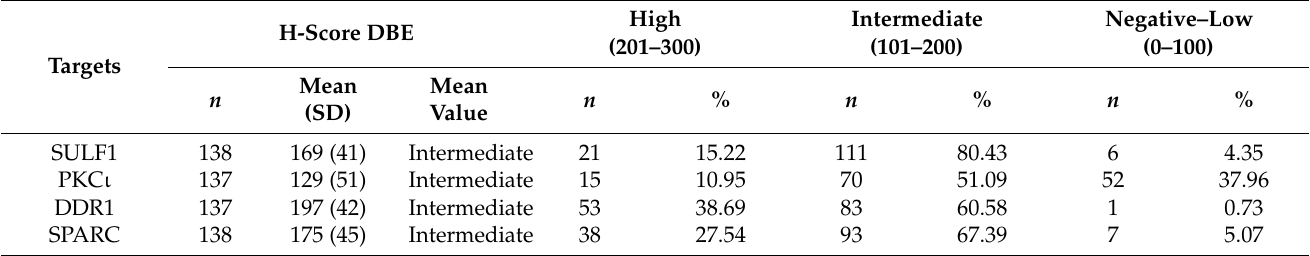
Table 1. Immunohistochemistry results of four targets in dysplastic Barrett’s